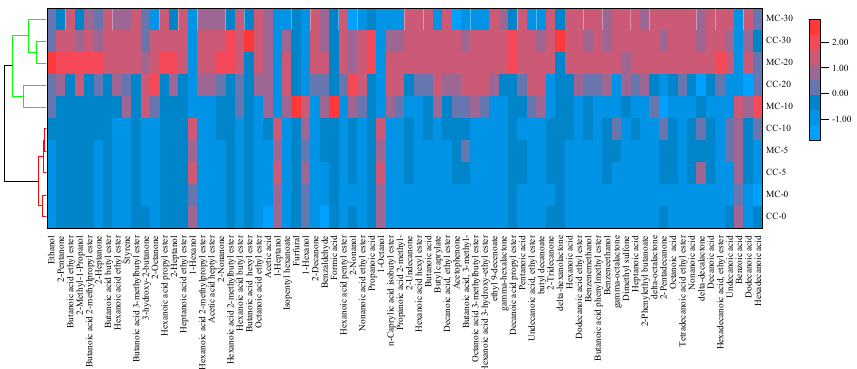
Figure 2. Heat map of the relative contents of volatile aroma compounds in CC and MC during the 30-day ripening period. Data presented in the heat map are in the log10 scale. CC and MC represent cheese samples collected from control cheeses and Monascus -fermented cheeses, respectively. CC-0: cheese samples of the control group ripened for 0 days.